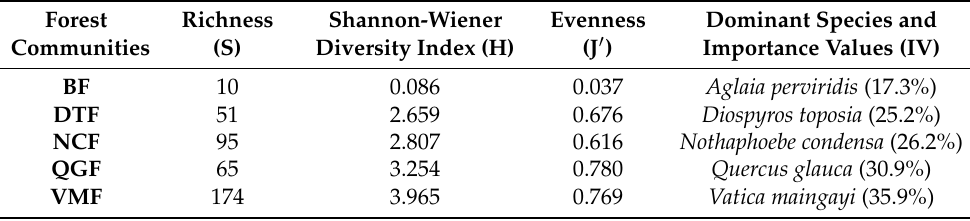
Table 1. Species diversity values among forest community types in Htamanthi Wildlife Sanctuary in Myanmar. Values in parenthesis are the importance values of the dominant tree species. Forest